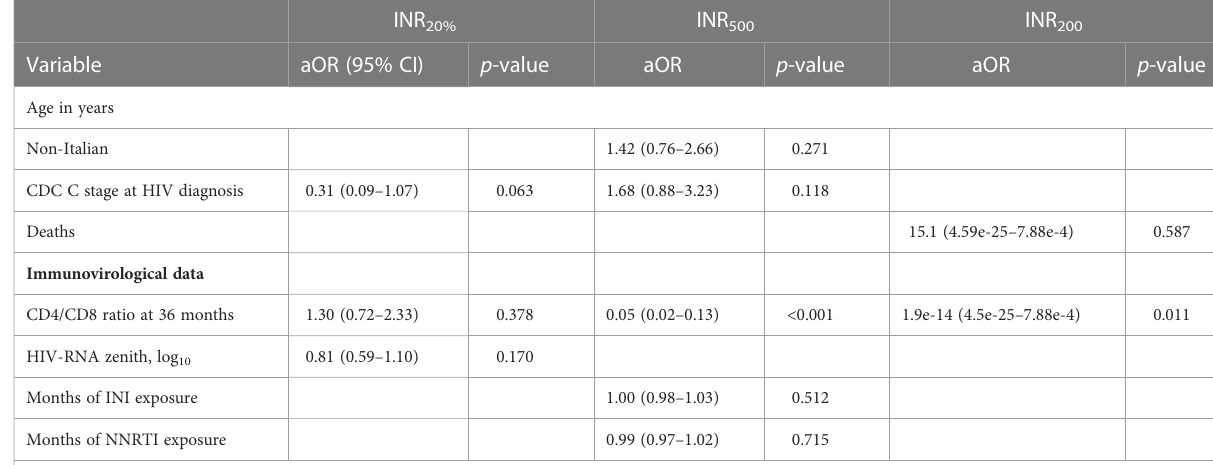
TABLE 7 Multivariable analysis of factors associated to INR 20% , INR 500 and INR 200 , including CD4/CD8 ratio at 36 months